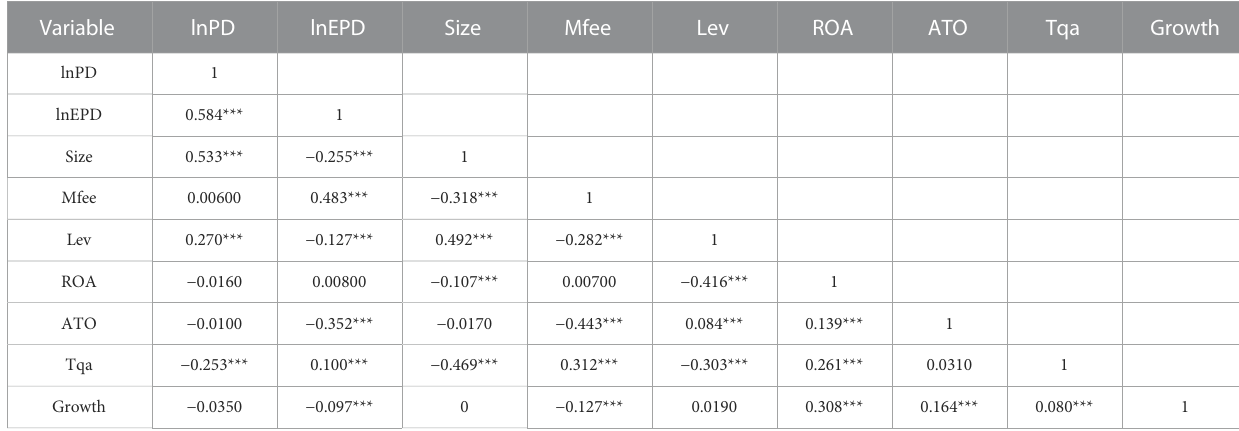
TABLE 2 Collinearity